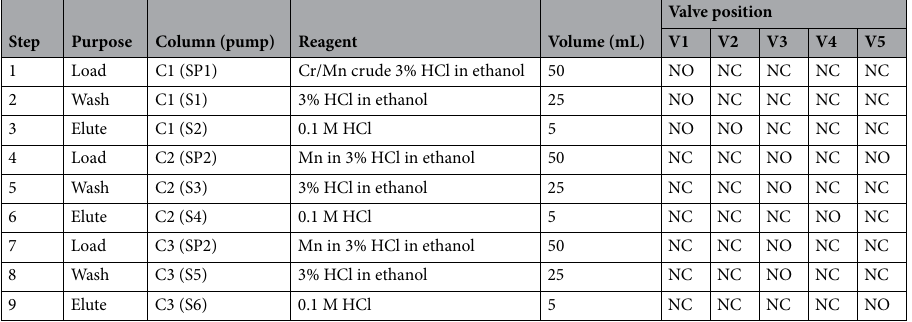
Table 3. Chemical separation procedure for the load-wash-elute sequence for a three-column system for the purification of 52 Mn from the cyclotron bombarded Cr targets 13